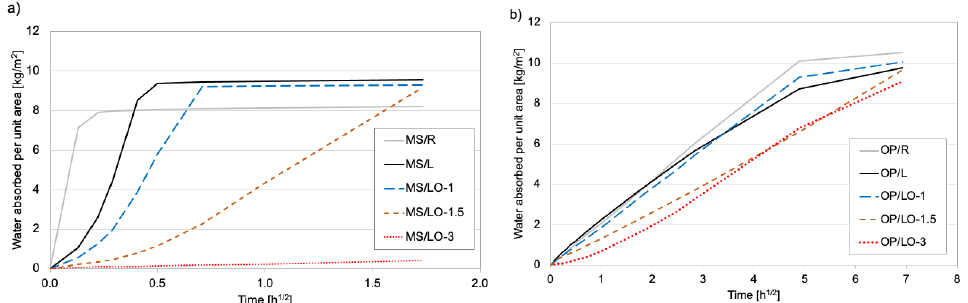
Figure 2. Water absorption by capillarity curves of ( a ) Mšené and ( b ) Opuka. The drying test was determined according to the RILEM recommendation [22] with four replicates of each stone and limewash type. The specimens were saturated with pure water by capillarity through the bottom surface (i.e., untreated surface) until reaching con- stant mass. Afterwards, the bottom surface was sealed with parafilm, and the specimens were left to dry only through the top (treated) surface in a room at constant thermohygro- metric conditions (20 °C, 50% RH). The drying conditions were monitored with thermo- hygrometers placed close to the specimens and registered a variation of 20 ± 3 °C and 50 ± 7%. All samples were tested at the same time in the same acclimatized room. The drying curves with pure water are given in Figure 3, and the respective drying rate values calcu- lated from the curves are given in Table 3. Figure 3. Drying curves with pure water of ( a ) Mšené and ( b ) Opuka stone. The same specimens used for the drying test with pure water were saturated by capillarity with a sodium chloride (NaCl) solution. Sodium chloride was selected because it is a common salt detected in ancient buildings worldwide. Though NaCl is more common in buildings located in coastal areas, it can also be present in regions far from the sea where water frequently freezes during winter, due to its long-term use as a de-icing agent. A sodium chloride solution with a concentration required to introduce 1 wt.% of salt in each stone type in respect to its dry weight was used. This concentration was chosen based on the highest typical NaCl content detected in porous building materials according to the KIK-IRPA salt database [23]. Hence, a salt solution concentration of 11.6% was used by dissolving the required amount of NaCl (ACS reagent > 99.0%) in pure water at ca. 20 ◦ C. The specimens were saturated by capillarity through the bottom surface (uncoated).